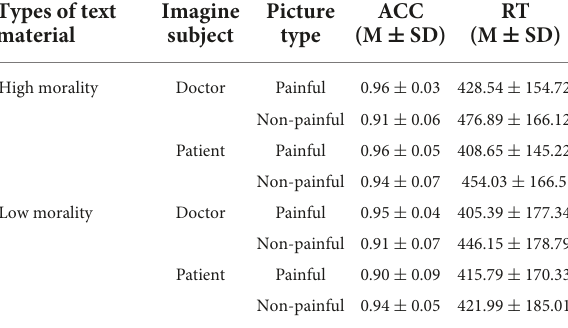
TABLE 2 Accuracy and reaction time